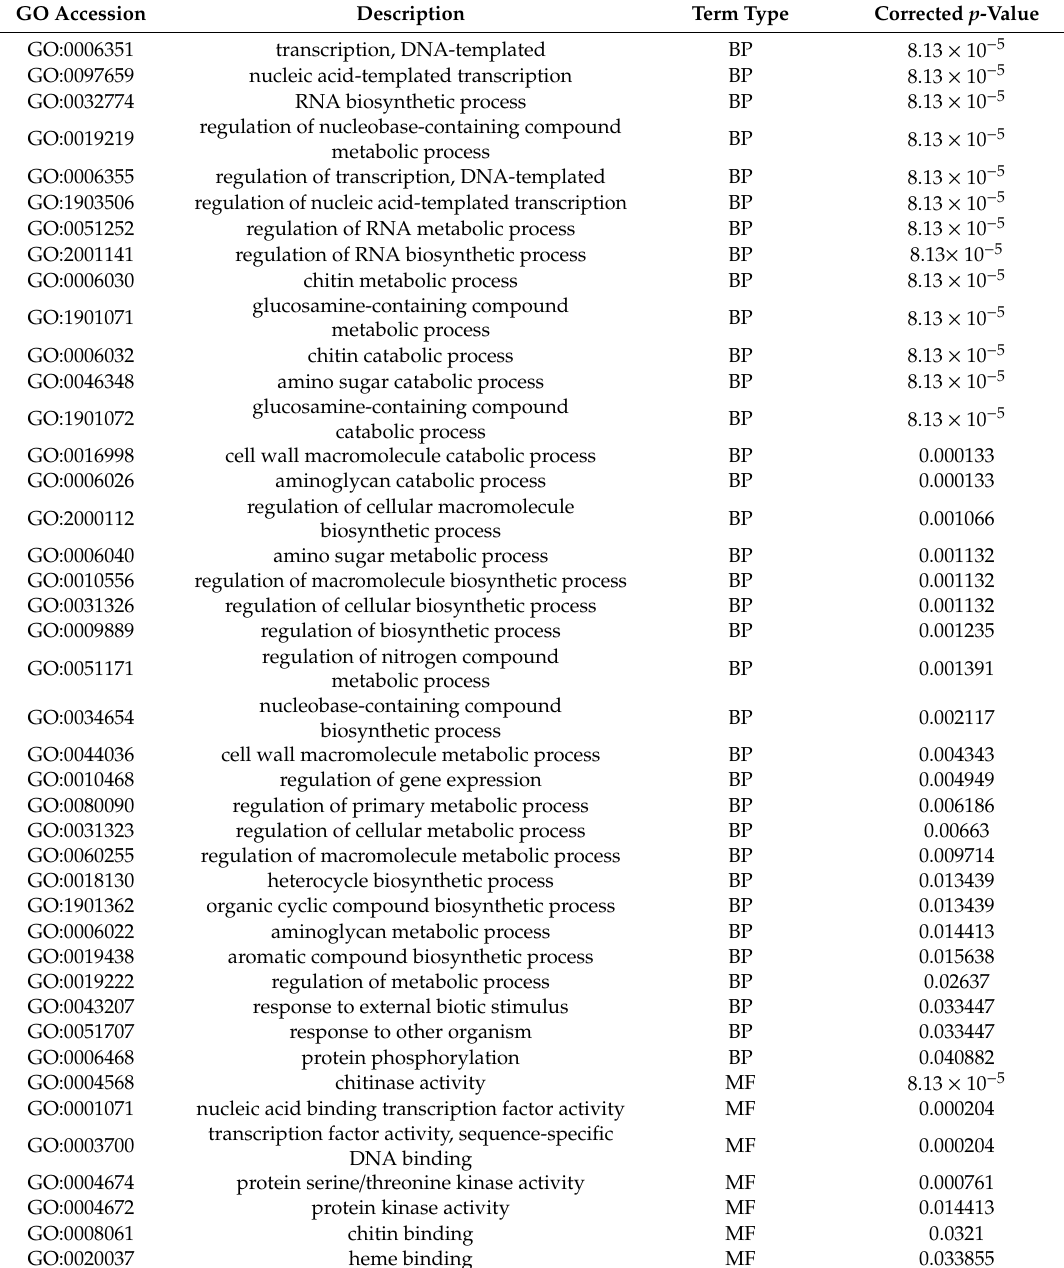
Table 2. Enriched GO terms for the upregulated DEGs in CEVd-infected citron plants.